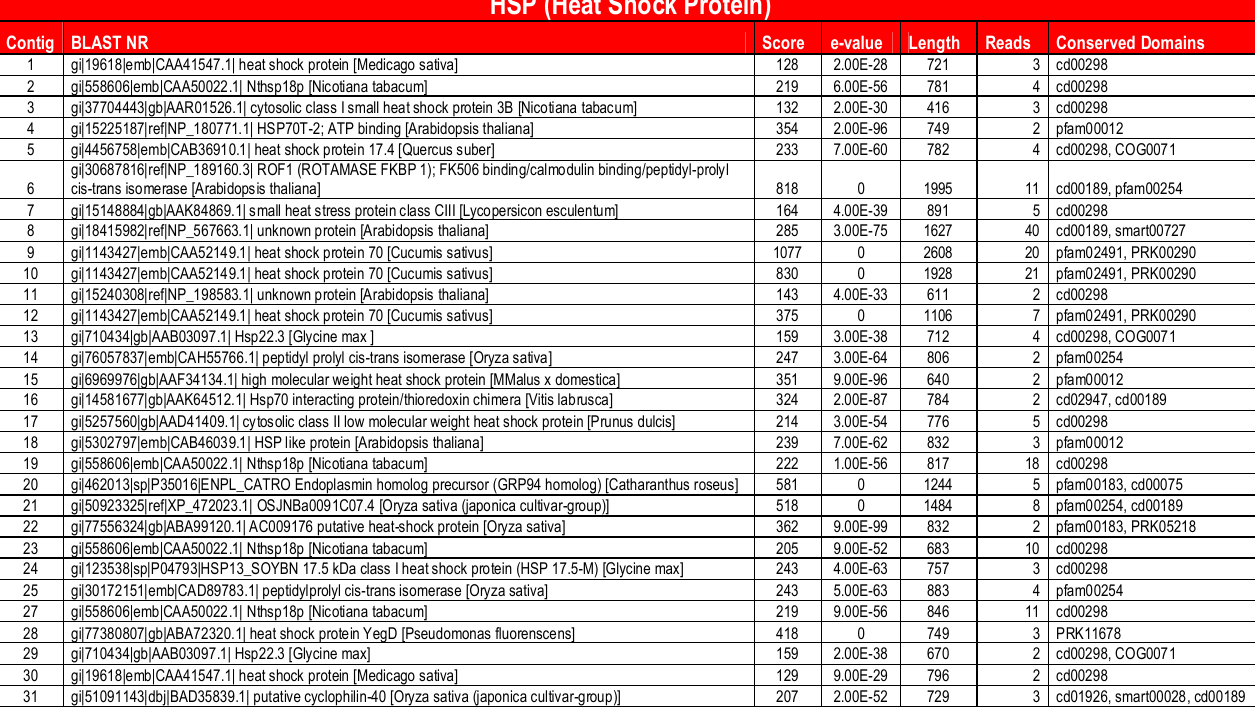
Table S8 : EST-Contigs with e-value < e -20 and score > 100 obtained in the Project HSP (Heat Shock Protein), and their blast hit, score, e-value, size, number of reads, and conserved domains from putative proteins. HSP (Heat Shock Protein) Contig BLAST NR Score e-value Length Reads Conserved Domains 1 gi|19618|emb|CAA41547.1| heat shock protein [Medicago